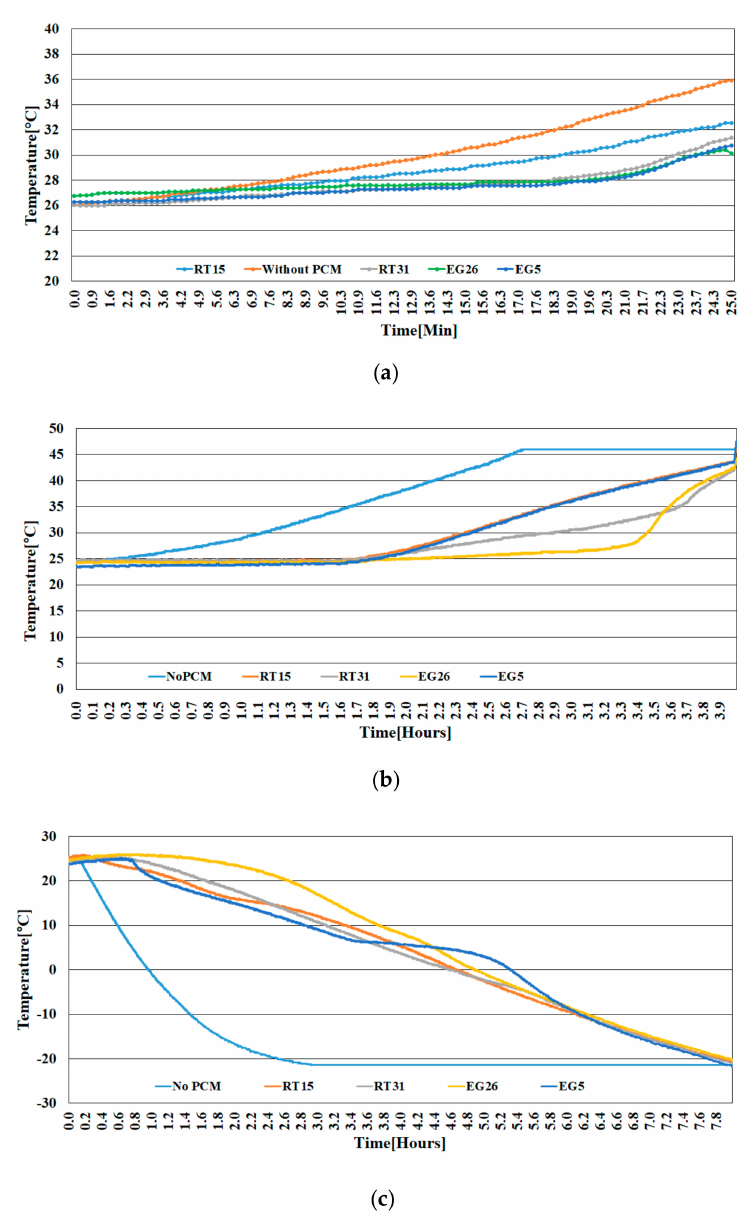
Figure 10. Experimental result of T max on single pouch battery with and without PCM. ( a ) At room temperature, ( b ) during hot soaking, and ( c ) during cool